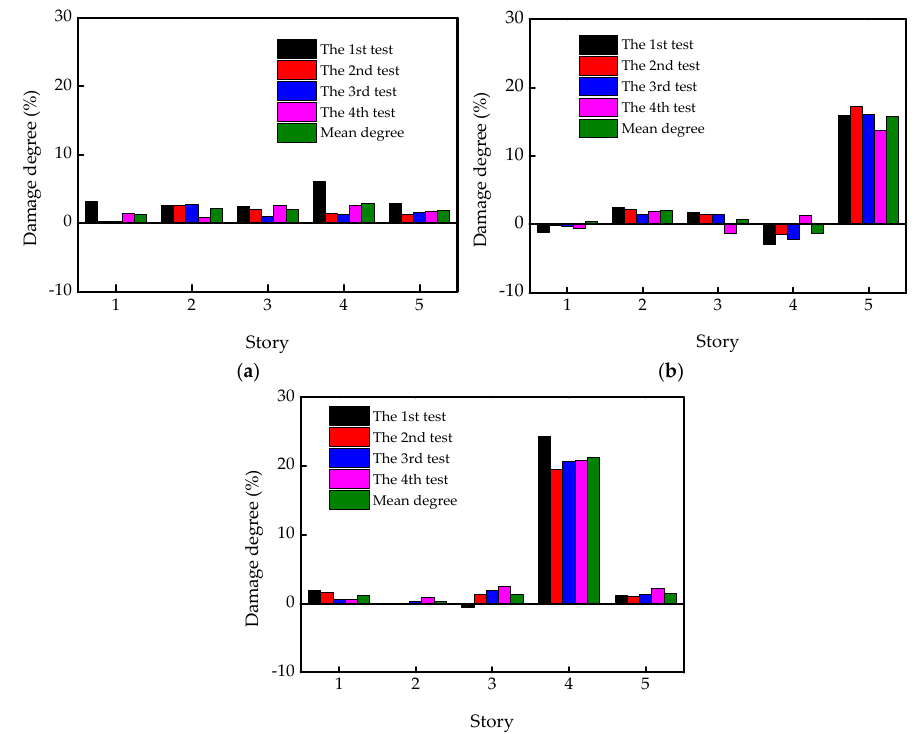
Figure 18. Identified damages at different damage cases: ( a ) case 1; ( b ) case 2; ( c ) case